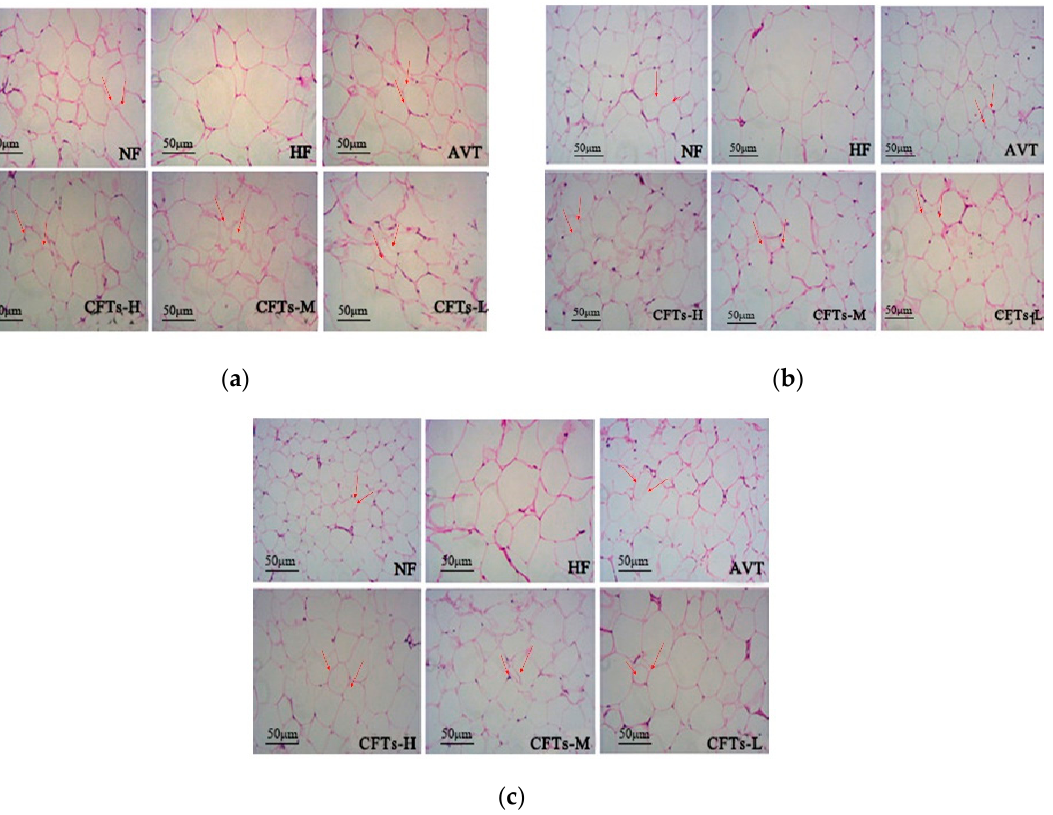
Figure 7. Adipose tissues histology. ( a ) perirenal adipose tissues, ( b ) subcutaneous adipose tissues, and ( c ) epididymal adipose tissues from different groups of rats (200×) after 6 weeks of treatment. Tissue sections were stained with hematoxylin and eosin (H & E).